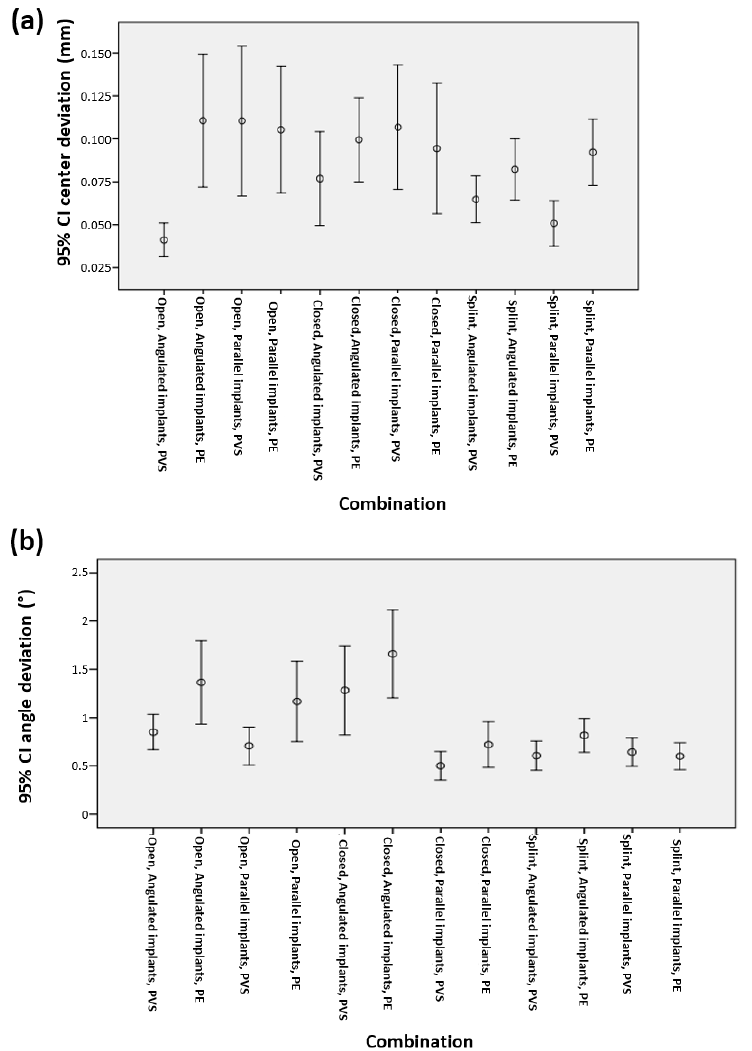
Figure 16. Graphical representation of ( a ) the mean deviation from the implant center (mm) ( b ) and the mean deviation angle (°) for all possible combinations of impression method, implant group and material type.